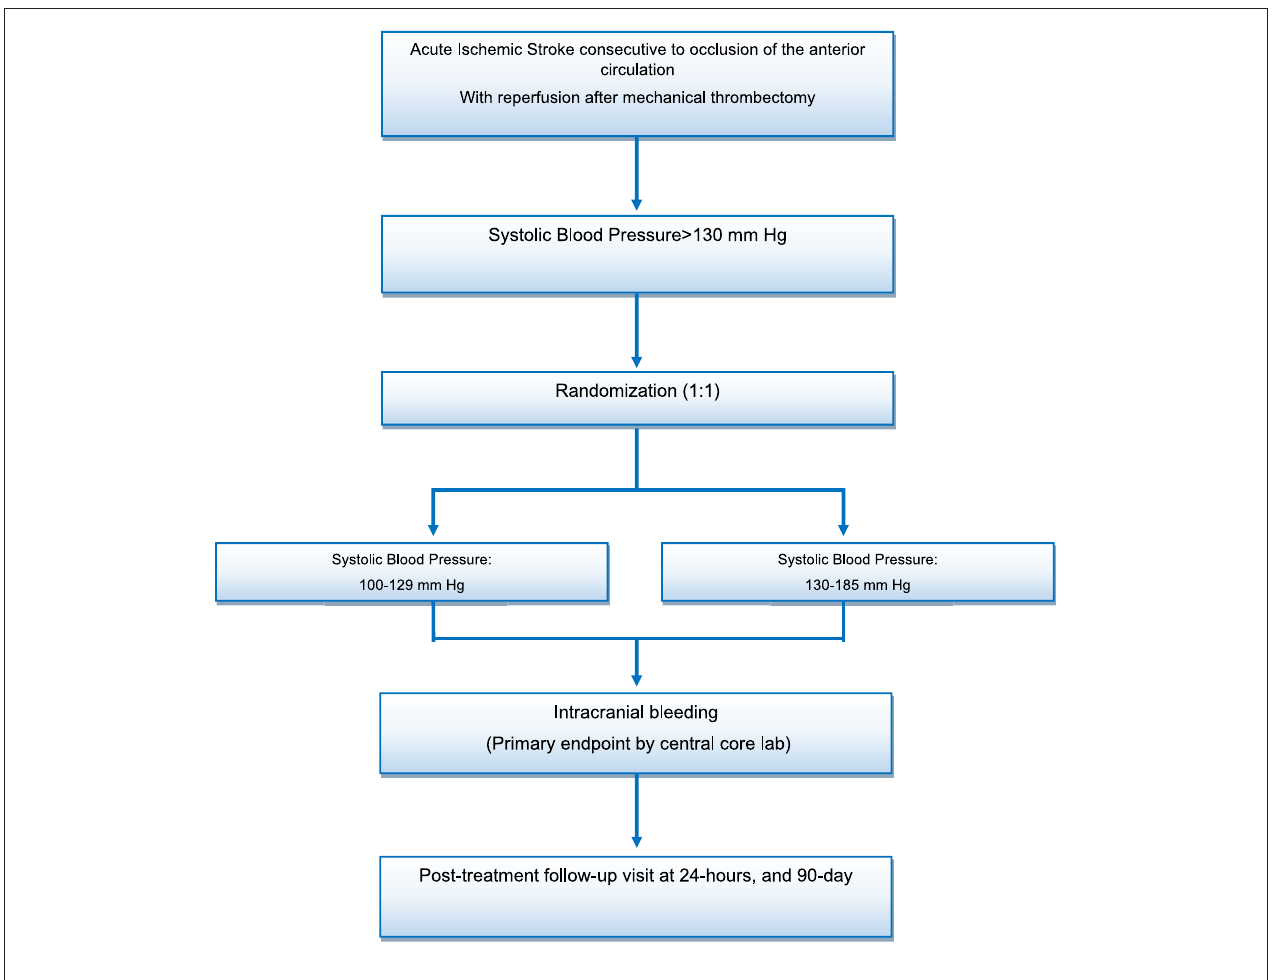
FIGURE 1 | Patient flow